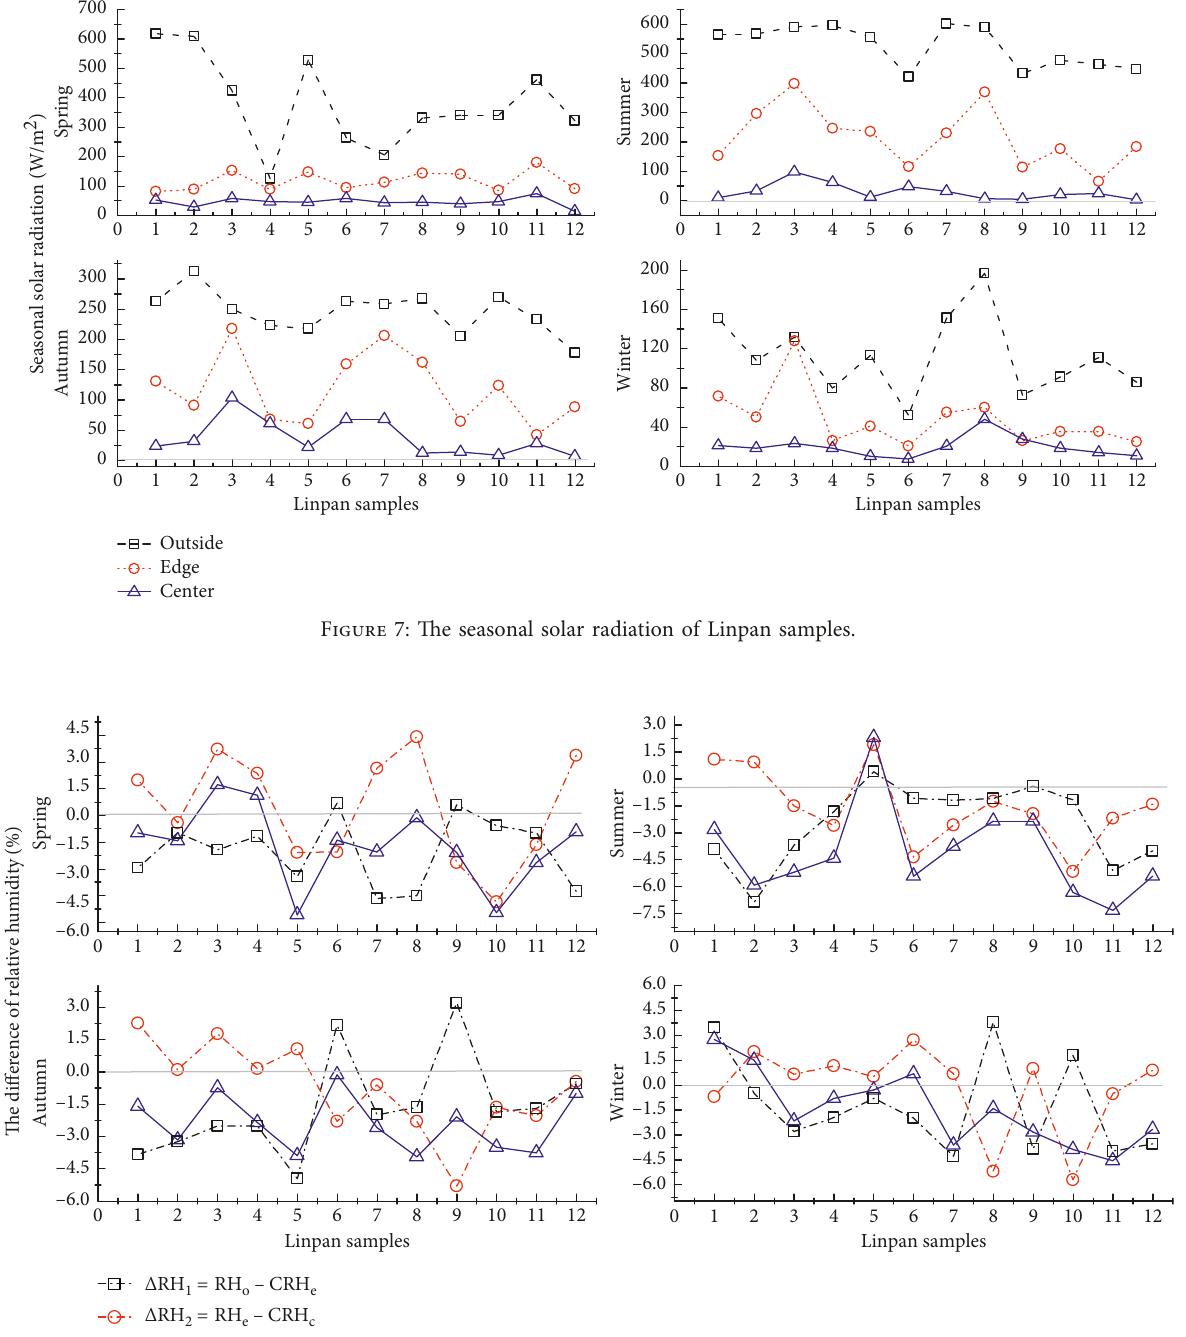
Figure 8: The seasonal relative humidity of Linpan samples.